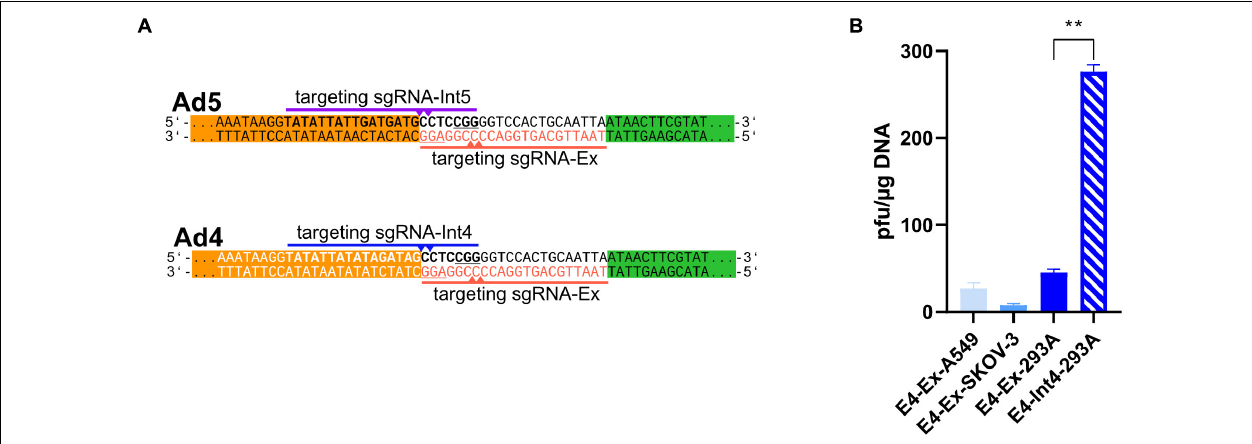
FIGURE 3 | ITR-near CTR induced also efficient rescue of recombinant adenoviruses based on HAdV-4. (A) Similarly to the HAdV-5-based constructs (upper panel), a recombinant HAdV-4 based bacmid was constructed (lower panel), which was flanked with ACT sequences (red, PAM is underlined) at both ITRs (here, the right ITR is shown, white letters). This sequence can be targeted by the universal sgRNA-Ex, like for the HAdV-5 based constructs (upper panel). Here also another sgRNA (sgRNA-Int4, blue, PAM is underlined) targeting the HAdV-4 ITRs (bold) can induce Cas9-mediated cleavage at the ITRs (blue triangles). (B) The rAd reconstitution efficiencies were determined after co-transfection of A549, SKOV-3, and 293A cells with pBWH-E4- (cid:49) E3 with either pAR-gRNA-Cas9F-Amp expressing sgRNA-Ex (E4-Ex) or with pAR-Int4-Cas9F-Amp (E4-Int4, for 293A cells only). The primary rescue efficiencies were obtained as in Figure 1B . A549-Ex and SKOV-3-Ex were tested twice in technical duplicates, and error bars represent spread of results. E4-Ex and E4-Int4 were done three times in technical duplicates, and error bars represent standard deviation. Significance was calculated using unpaired t -test comparing E4-Ex and E4-Int4. ** p < 0.01.